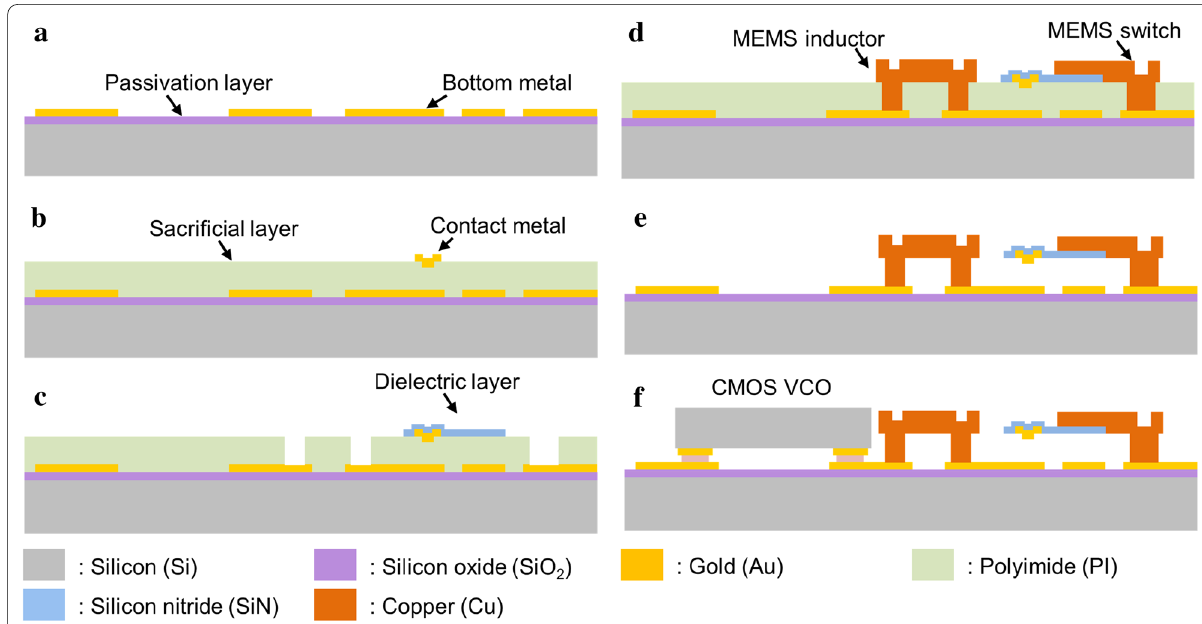
Fig. 3 Fabrication process of the proposed VCO integrated with a MEMS tunable inductor. a The bottom metal layer was deposited and patterned by a lift‑off process on a thermally‑oxidized, 4‑inch silicon wafer. b Polyimide as a sacrificial layer was coated on a silicon substrate, and the contact metal was deposited and patterned. c The dielectric layer was deposited and patterned using plasma‑enhanced chemical vapor deposition (PECVD) and reaction ion etching (RIE), respectively. Polyimide was patterned using RIE for forming anchors. d Cu metal was formed using an electroplating process. e The sacrificial layer was removed using an O 2 plasma etching process, and the MEMS tunable inductor was released from the substrate. f CMOS VCO was bonded on bottom pads that were connected to a tunable inductor using the flip‑chip bonding process